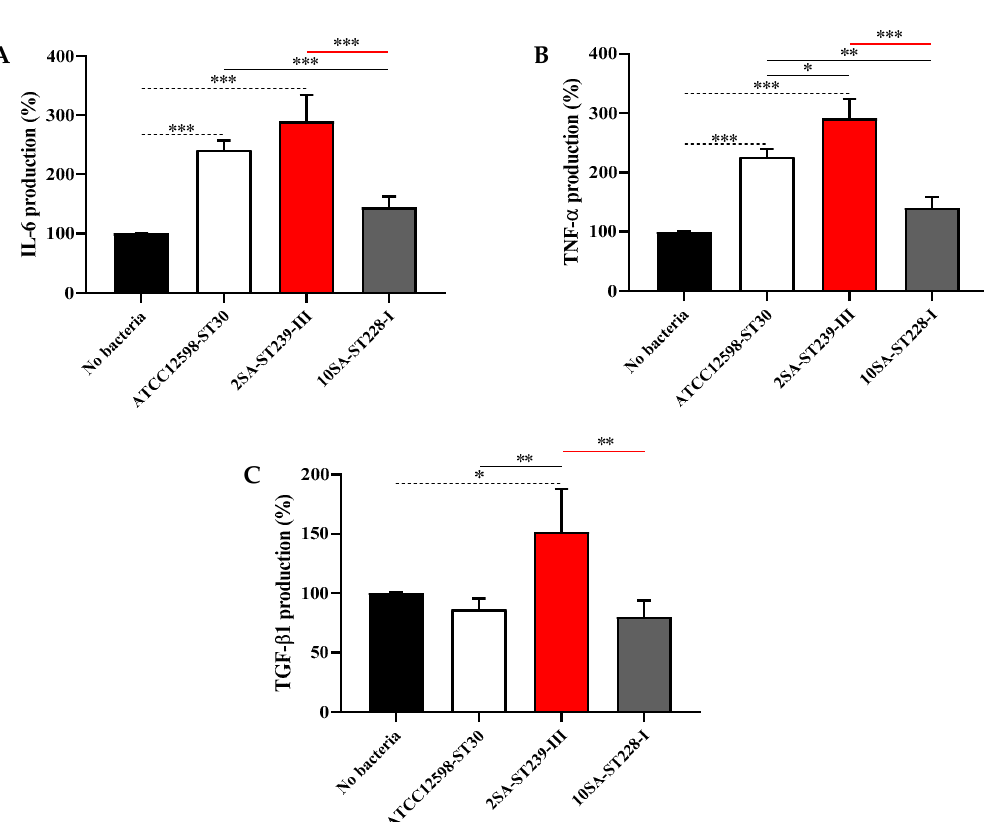
Figure 5. Modulation of interleukin 6 (IL ‐ 6), tumor necrosis factor alpha (TNF ‐α ), and transforming growth factor beta 1 (TGF ‐β 1) secretion by bacteria. Supernatants from uninfected (No Bacteria) MG ‐ 63 osteoblast ‐ like cells and MG ‐ 63 cells infected at an MOI of 100:1 with three different S. aureus strains for 24 h were analyzed using a Custom Multi ‐ Analyte ELISArray Kit. Each treatment was analyzed at least in triplicate. The production of each cytokine is expressed as the percent variation with respect to the production recorded in uninfected (control) cells. ( A ) IL ‐ 6, ( B ) TNF ‐α , and ( C ) TGF ‐ β 1. Values are means ± SD of three to four independent experiments. Significant comparisons between each experimental condition are indicated by lines. * Significantly different, p < 0.05; ** significantly different, p < 0.01; *** significantly different, p < 0.001.